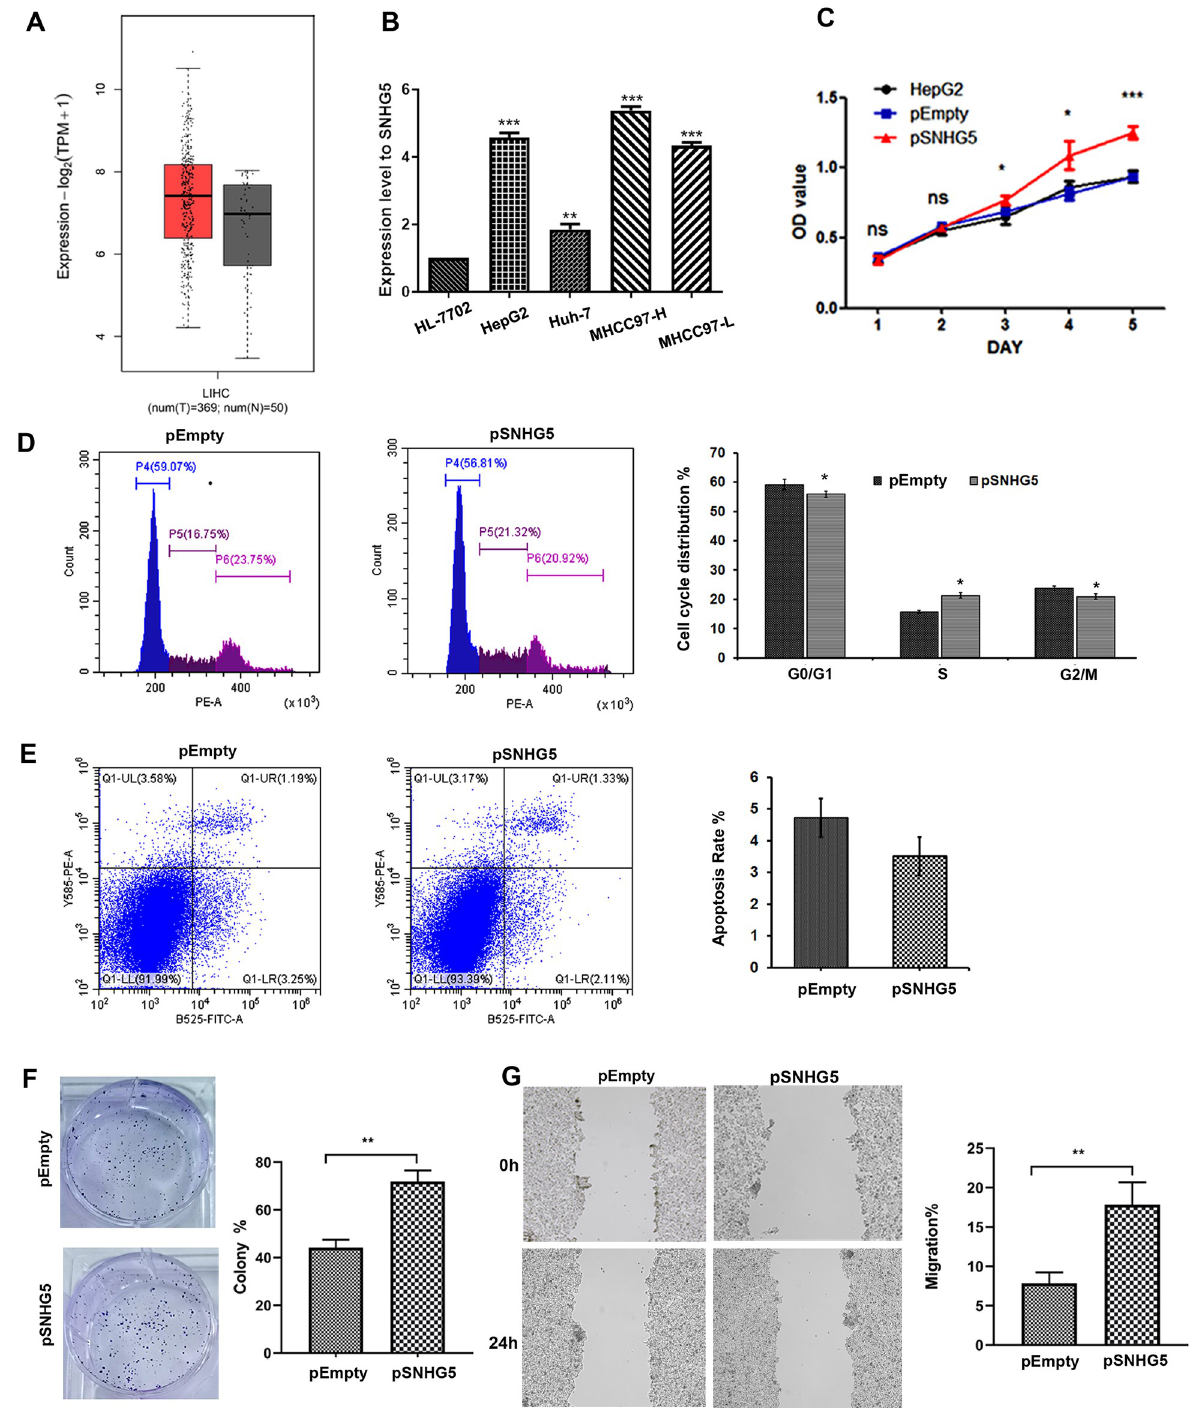
Fig 3. Overexpression of SNHG5 promotes proliferation and migration in HCC line. (A) The SNHG5 expression in HCC tissues and normal tissues. (B) Differential expression patterns of SNHG5 in different HCC cell lines. (C, D) Overexpression of SNHG5 promoted cell proliferation and the cell cycle; (E) repressed cell apoptosis, and increased the clonogenic survival ability (F) of HepG2 cells. (G) Wound healing assays in SNHG5 overexpressed HepG2 cells. � P < 0.05, �� P < 0.01, �� P < 0.001.